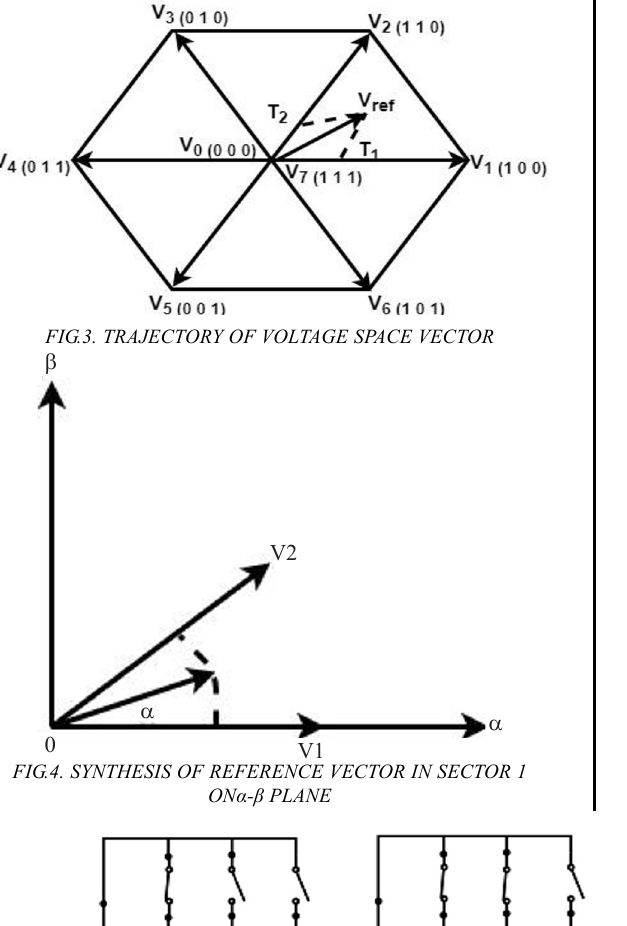
FIG.4. SYNTHESIS OF REFERENCE VECTOR IN SECTOR 1 ONα-β PLANE